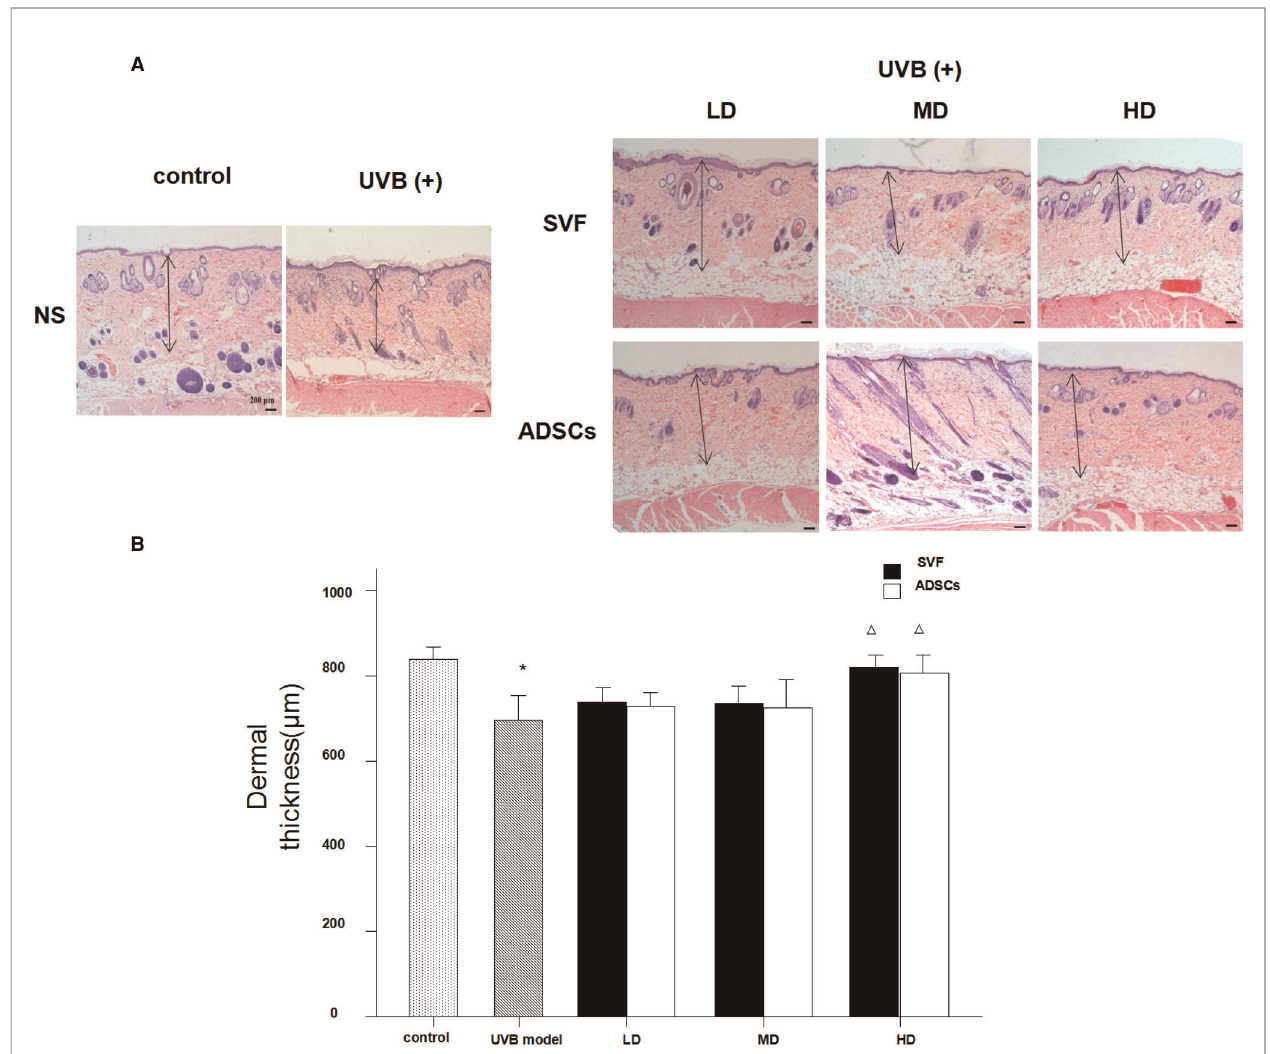
FIGURE 5 | Haematoxylin staining showed the changes of dermal thickness of nude rats exposed to UVB 28 days after SVF treatment (×40). ( A ) UVB exposure decreased dermal thickness and SVF and ADSCs treatment increased dermal thickness of aging skin. ( B ) The dermal thickness of UVB exposed group and SVF and ADSCs treatment groups. Mean±SD. n =6. * P <0.05 vs control group. △ P <0.05 vs UVB model